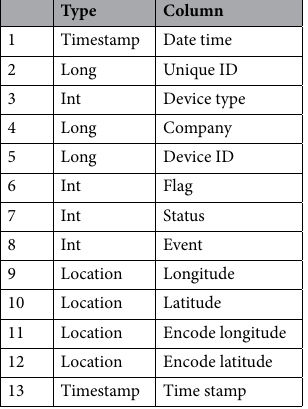
Table 1. City data set. The resolution of the data is enhanced to one meter in most cases through map- matching 19 . The data can represent the approximation of human social distance, which is based on Unique ID, Longitude, Latitude and Time stamp.